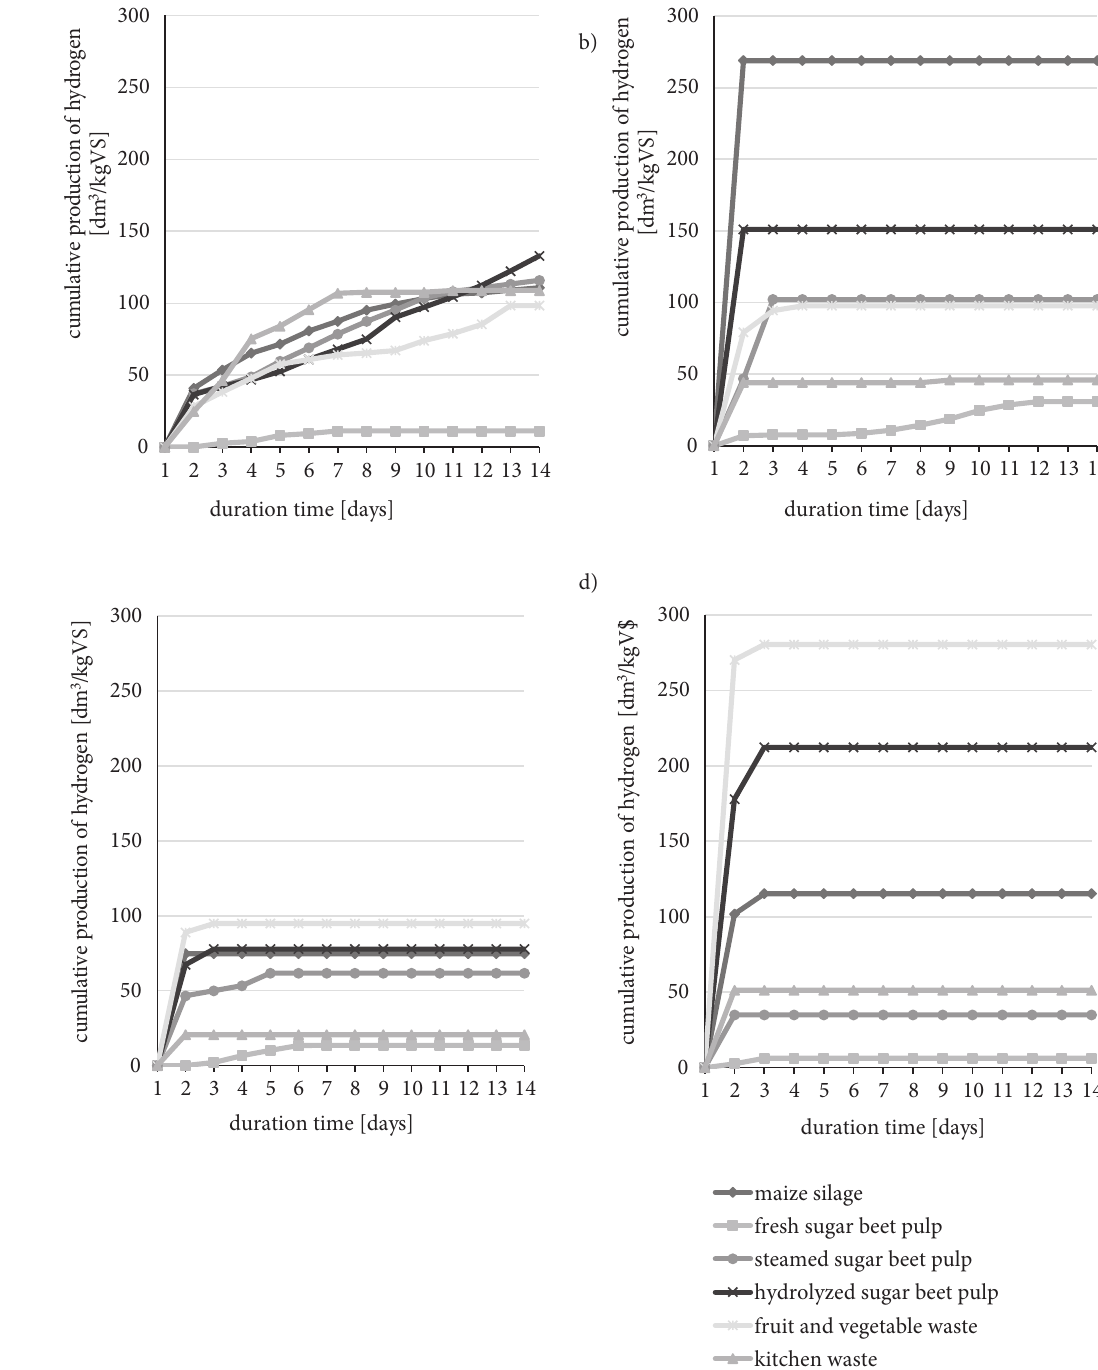
Figure 2. Cumulative hydrogen production a) – without correction, b) – with pH adjustment, c) – with thermal correction, d) – with pH adjustment and thermal correction in batch experiments from MS, steamed SBP, hydrolyzed SBP, fresh SBP, FVW and